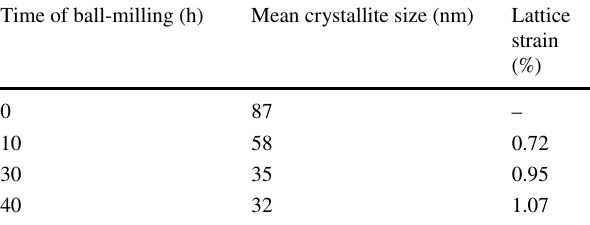
MgH (10, 30, and 40 h) are depicted in Fig. 4. Based on 2 Fig. 4b, after 10 h of milling, MgH cal and their mean size reached 338 nm. The presence of